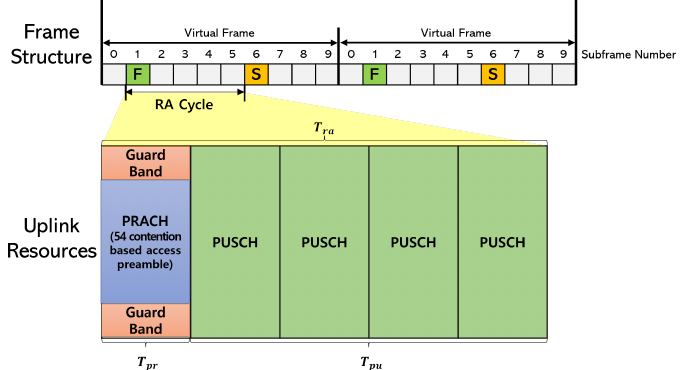
Figure 3. Frame structure of codeword-based random access (codeword length L c = 2 and PRACH configuration =